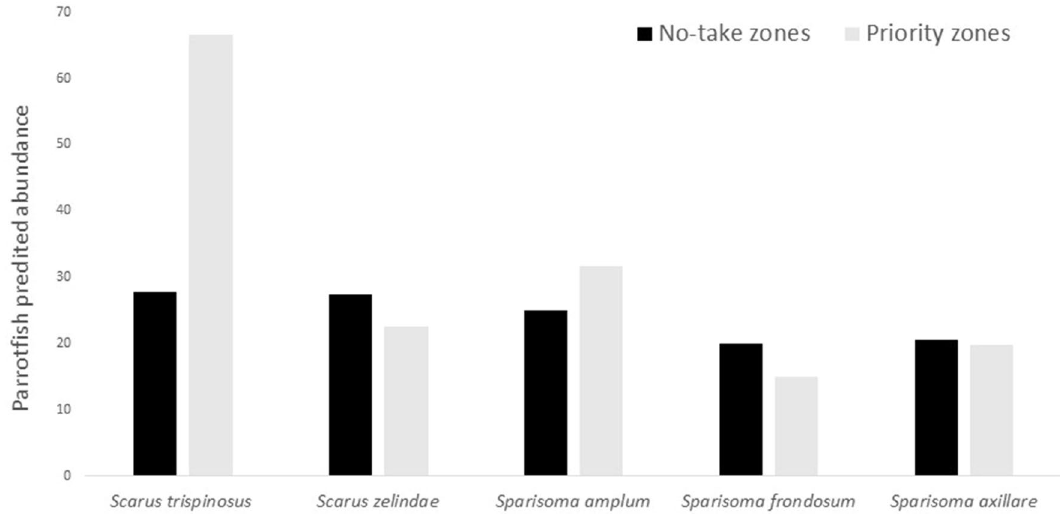
Figure 5. Predicted abundance for each parrotfish species within no-take and priority zones at MPA Costa dos